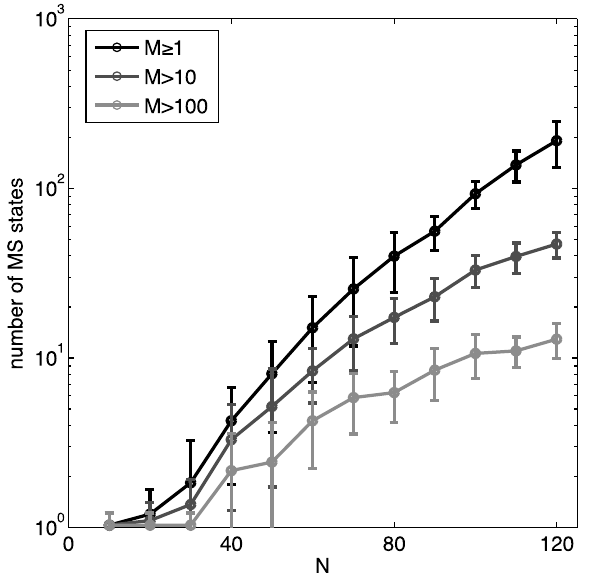
Figure 10. The number of identified metastable patterns. Every recorded pattern is assigned to its basin of attraction by descending on the energy landscape. The number of distinct basins is shown as a function of the network size, N , for K-pairwise models (black line). Gray lines show the subsets of those basins that are encountered multiple times in the recording (more than 10 times, dark gray; more than 100 times, light gray). Error bars are s.d. over 30 subnetworks at every N . Note the logarithmic scale for the number of MS states.